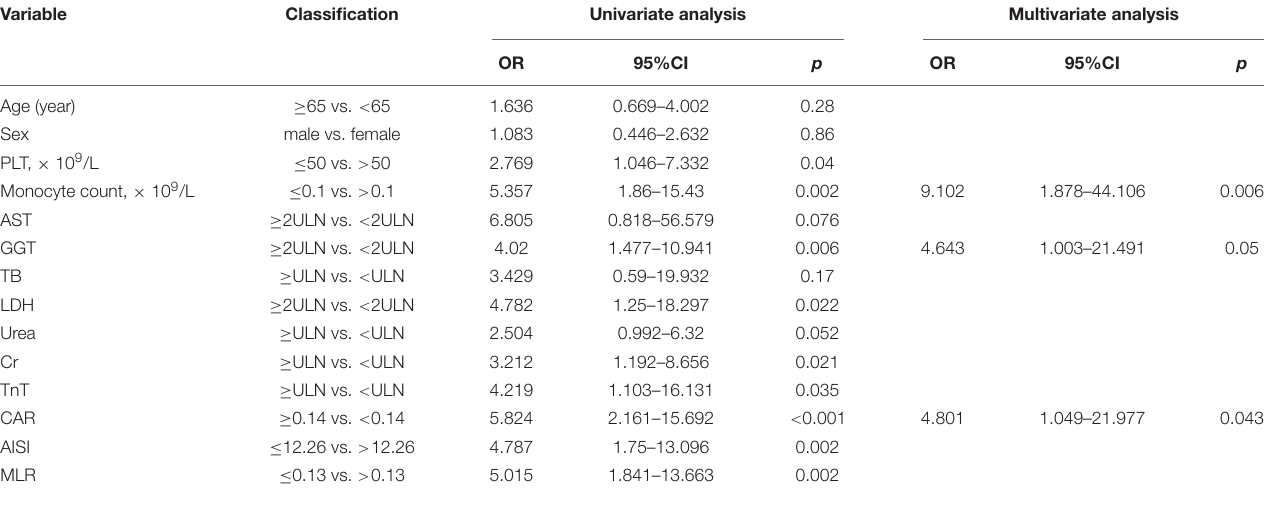
TABLE 3 | Logistic regression analysis of risk factors for prognosis in patients with SFTS.